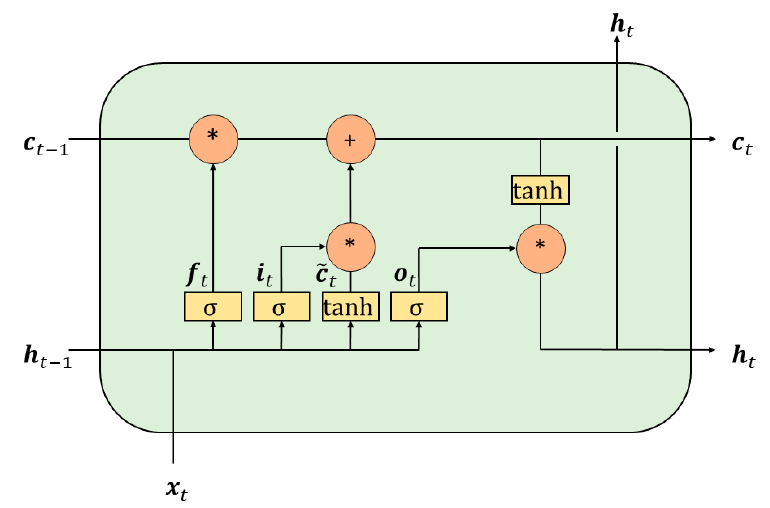
Figure 2. The structure of LSTM networks.